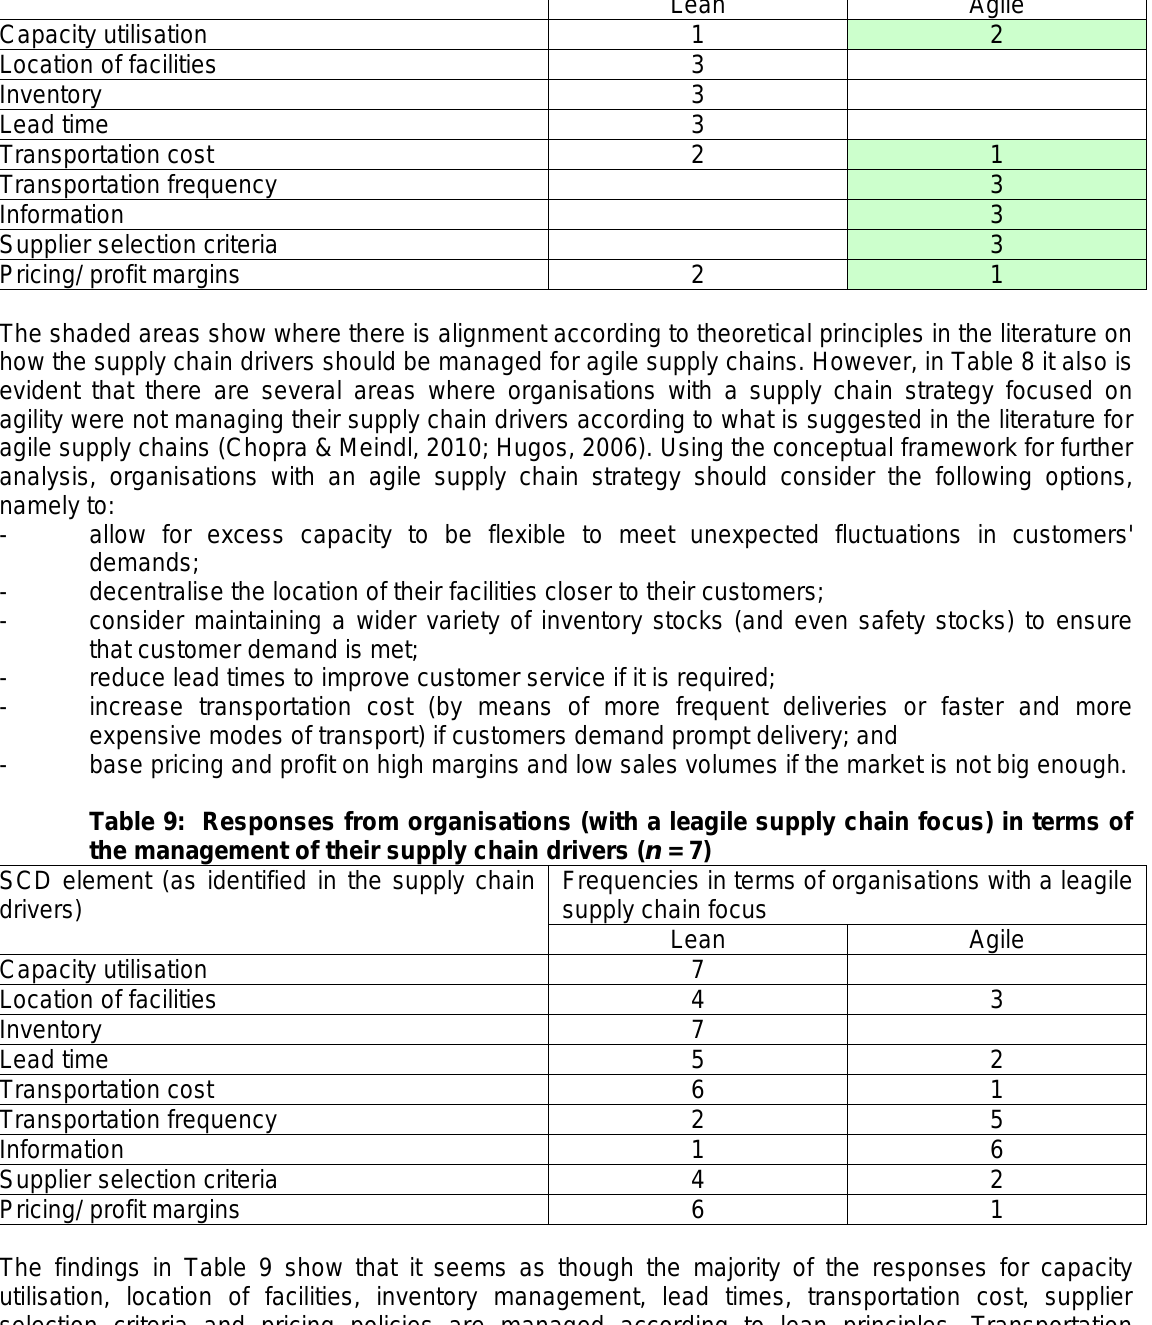
Table 8: Responses from organisations (with an agile supply chain focus) in terms of the management of their supply chain drivers ( n = 3) SCD element (as identified in the supply chain Frequencies in terms of organisations with an agile drivers) supply chain focus